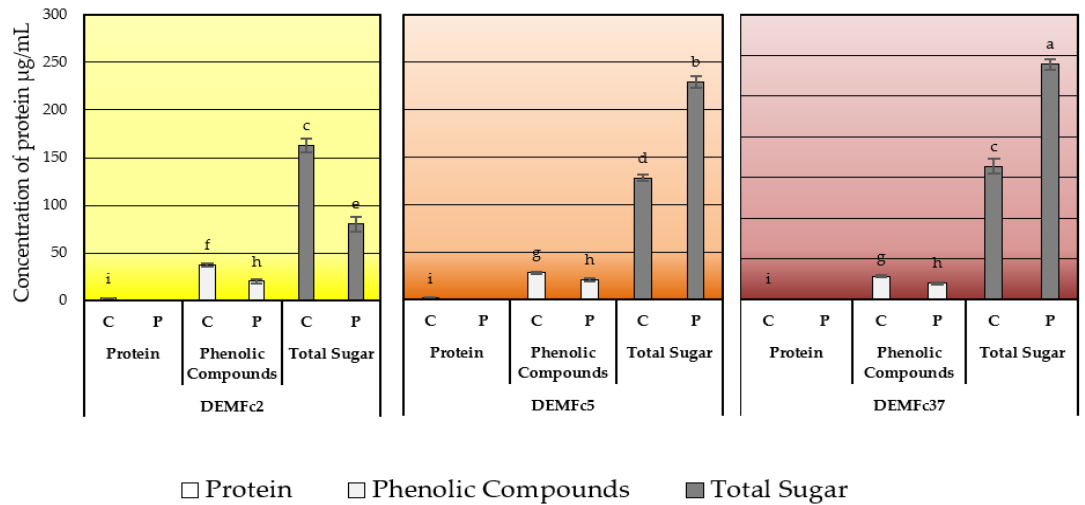
Figure 9. Concentration of protein, phenolic compounds and total sugar in water solution of crude ( C ) and proteolysed ( P ) EPS obtained from cultures of three F. culmorum strains: DEMFc2, DEMFc5, and DEMFc37. ANOVA with post hoc Tukey’s HSD test, p < 0.05. Mean values labeled with the same letter within the same series are not significantly different ( p > 0.05). Standard deviations are shown as deviation bars ( n = 9).